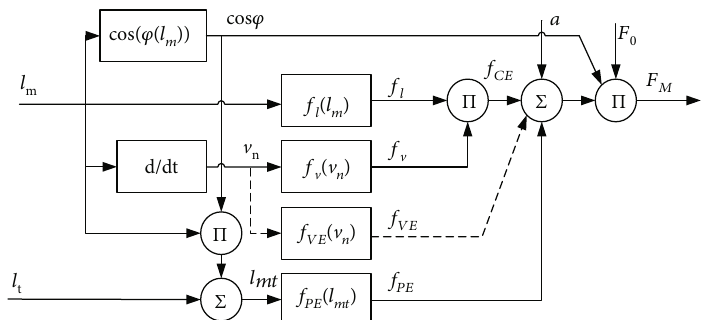
Figure 2: Calculation fl ow of the Hill musculotendon model.